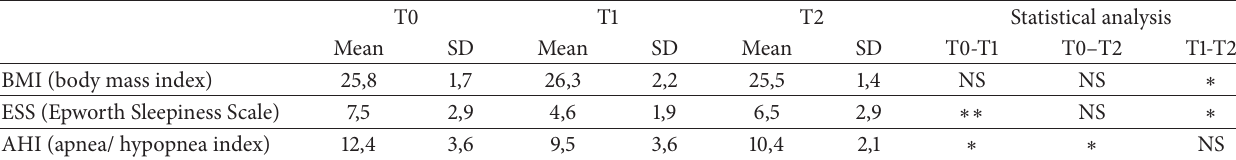
Table 1: Distribution of means (M) and standard deviation (SD) before treatment (T0), after 6 months (T1), and 48 months (T2) of treatment.